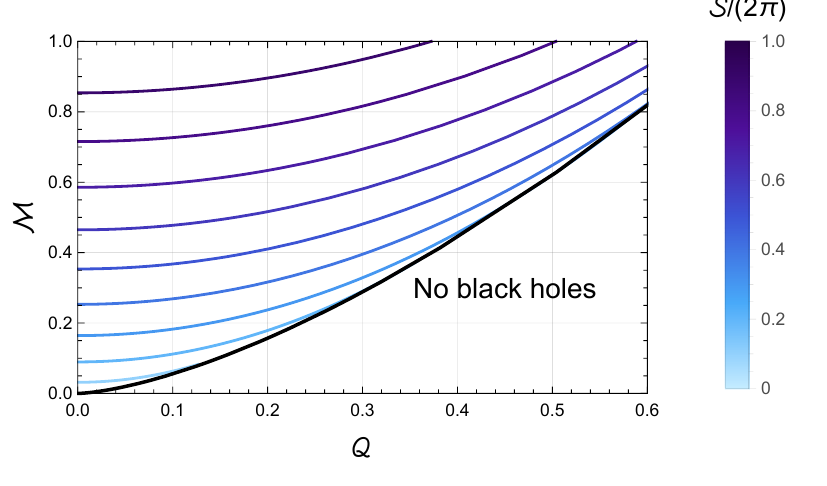
Figure 1 . Contours of the entropy density of the RNAdS 4 for S/ 2 π = 0 . 1 , 0 . 2 , . . . , 0 . 9